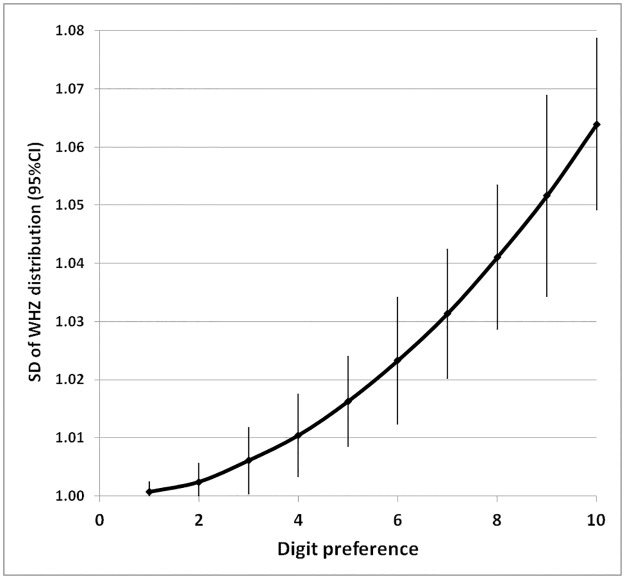
Effect of rounding/digit preference on the SD of WHZ distribution from 50 simulated surveys.The terminal digit of the weights of the children were manipulated using the excel formula: round(weight/n)*n to 0.1Kg where n varied from 1 to 10. The error bars are the 95% confidence intervals.